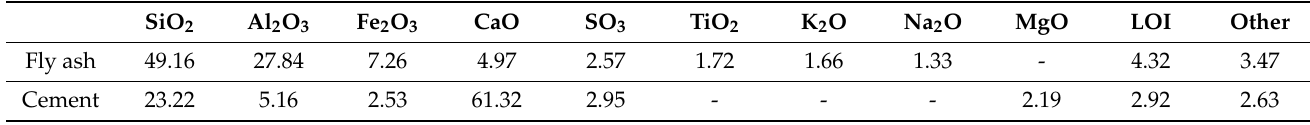
Table 1. Chemical composition of fly ash and cement